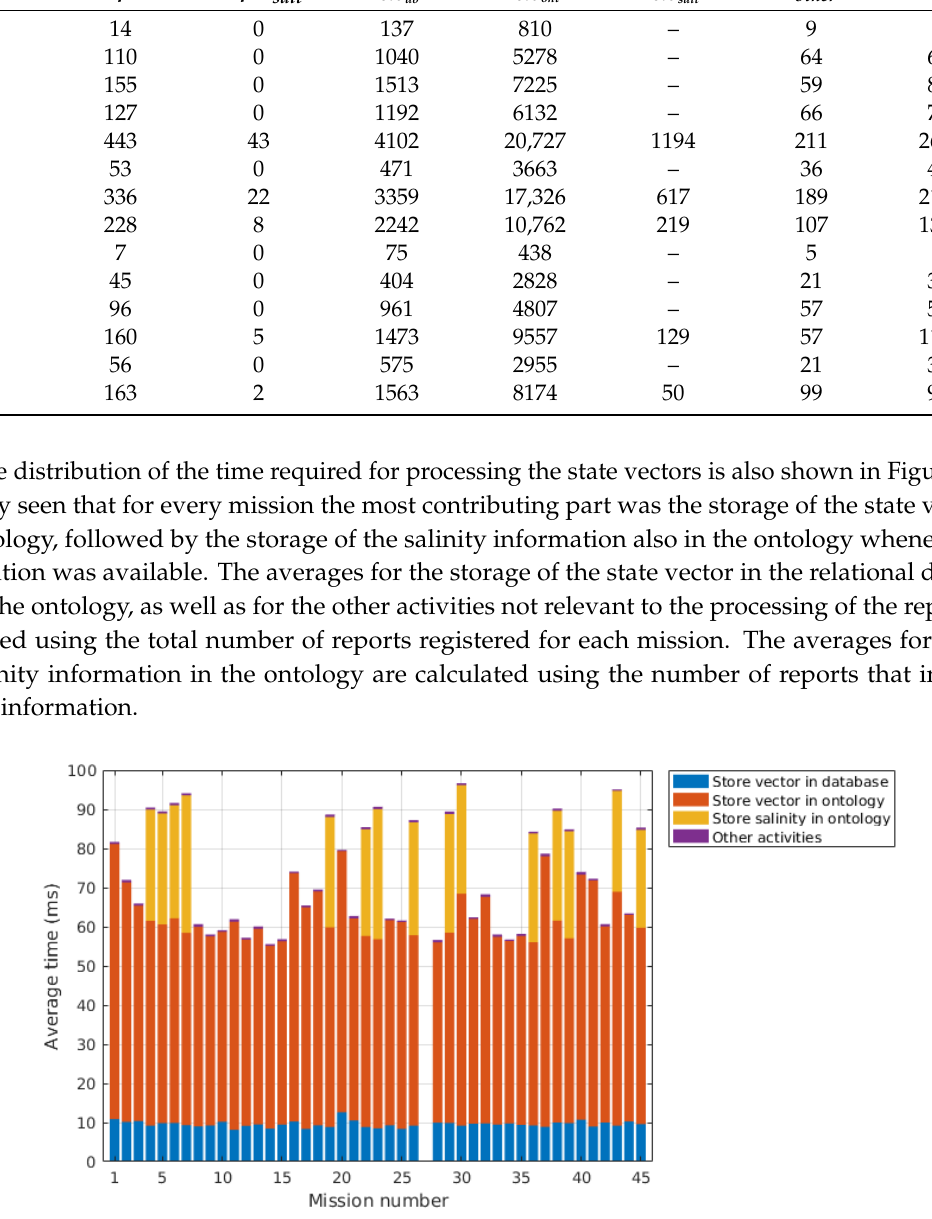
Figure 34. Distribution of times required for processing the state vectors.